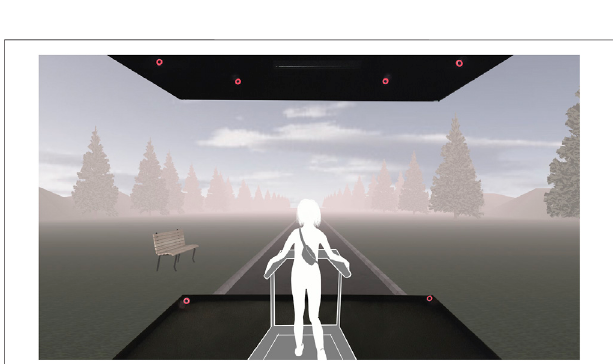
FIGURE 2 | Illustration of the CAVE setup with its three screens. Participants walked on a treadmill in a variety of dynamic virtual environments, encountering both landmark (here: a bench) and endpoint objects along their way while their eye movements were continuously tracked and recorded. A subset of the infrared-cameras is marked